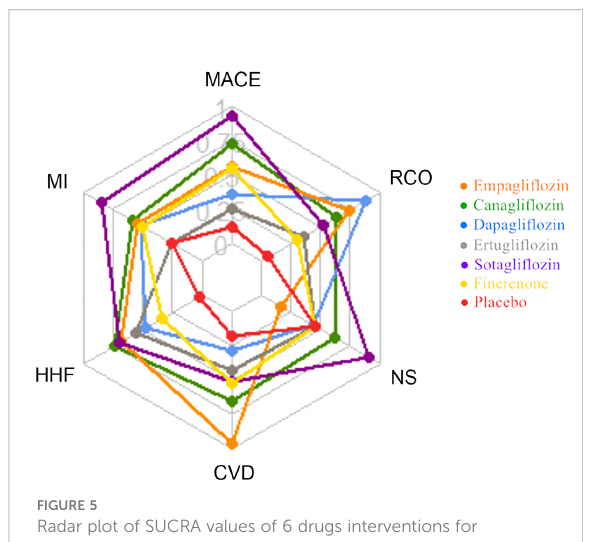
FIGURE 5 Radar plot of SUCRA values of 6 drugs interventions for cardiorenal and renal outcomes in T2DM